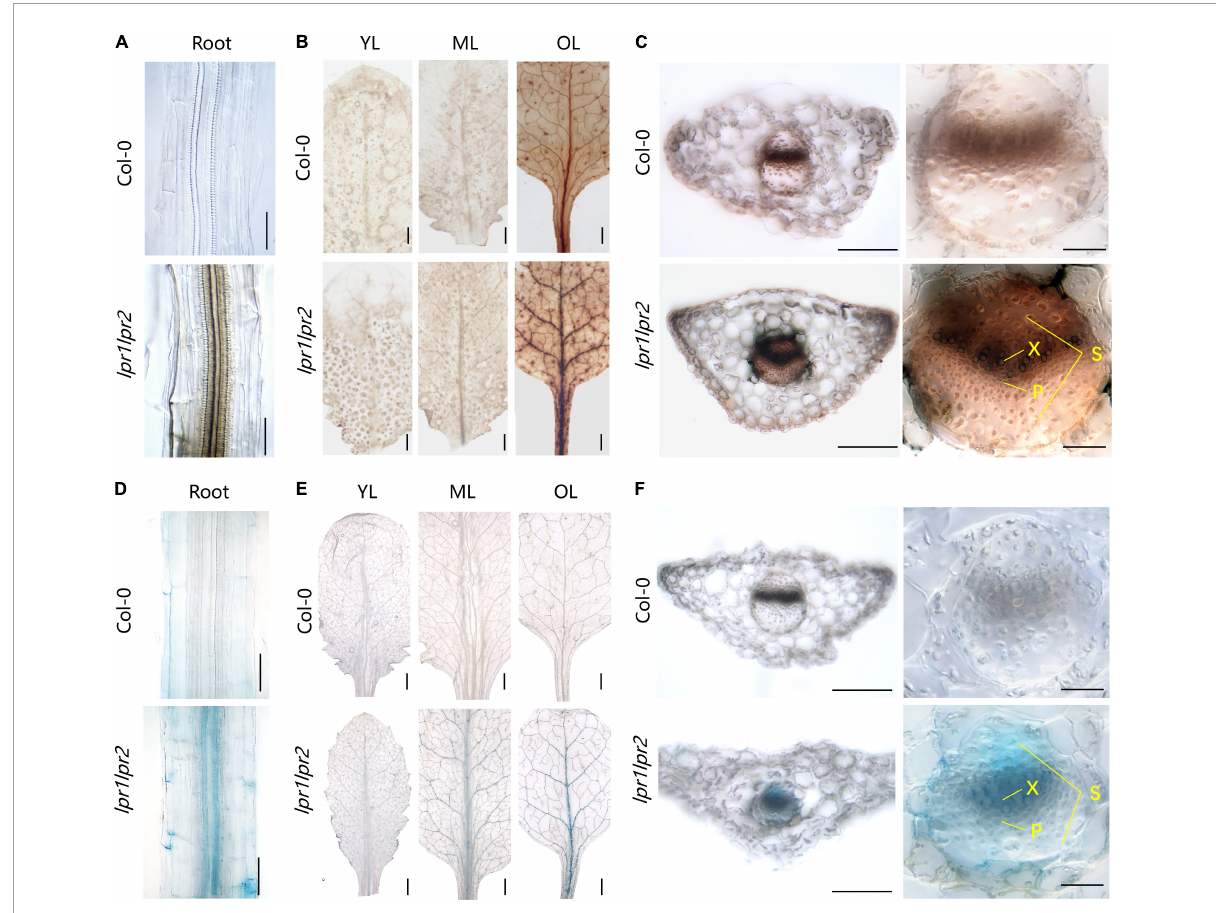
FIGURE5 Iron accumulation in the vascular tissues of lpr1lpr2 double mutant. (A–C) Perls/DAB staining of Col-0 and lpr1lpr2 . (A) Close-up views of roots. (B) Leaves from different positions. OL, old leaf; ML, middle leaf; YL, young leaf. (C) Cross sections of old leaves (left) and close-up views of vascular vessels (right). X, xylem; P, phloem; S, sclerenchyma. (D–F) Turnbull staining of Col-0 and lpr1lpr2 . (D) Close-up views of roots. (E) Leaves from different positions. (F) Cross sections of old leaves and close-up views of vascular vessels. Col-0 and lpr1lpr2 were